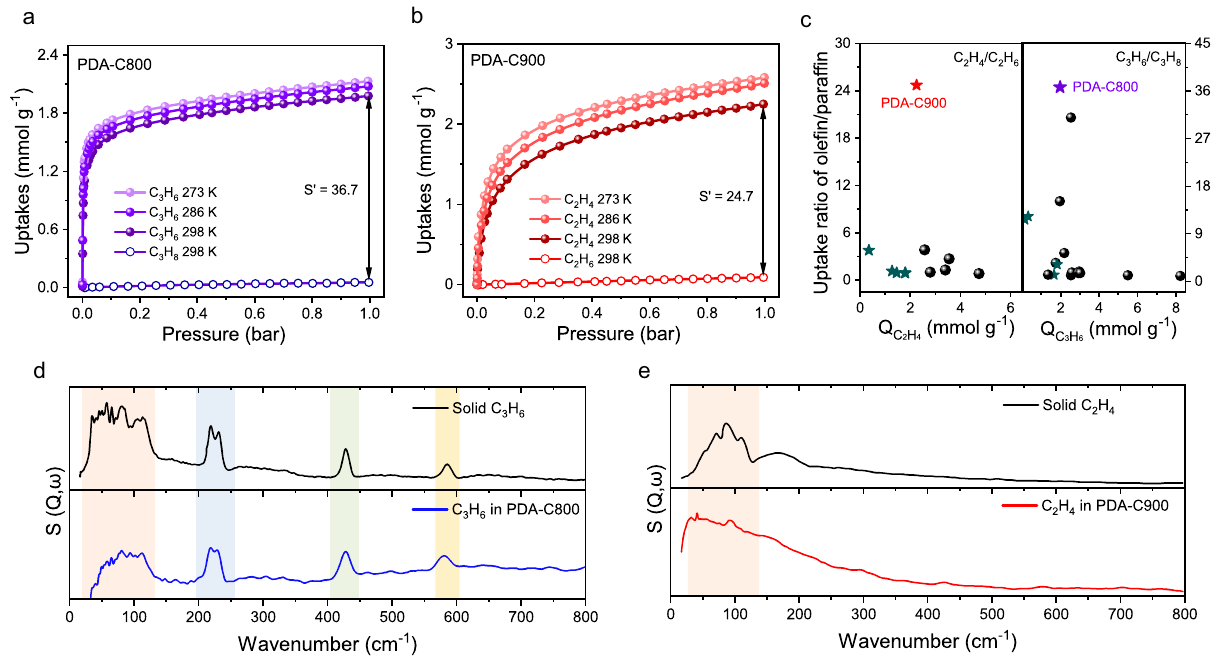
Fig. 4 | Static sorption property of ole fi ns and paraf fi ns. Single-component gas adsorption isotherms of a C 3 H 6 and C 3 H 8 on PDA-C800 and b C 2 H 4 and C 2 H 6 on PDA-C900 atvariedtemperatures. The separation factor (S ’ ) wascalculated by the uptake ratio of ole fi n/paraf fi n at 298K and 1.0bar; c Comparison of the numberof ole fi ns adsorbed (Q) and ole fi n/paraf fi n separation factor of PDA-Cx with state-of- the-art porous carbon adsorbents (PDA-Cx marked as pentagram). The details are